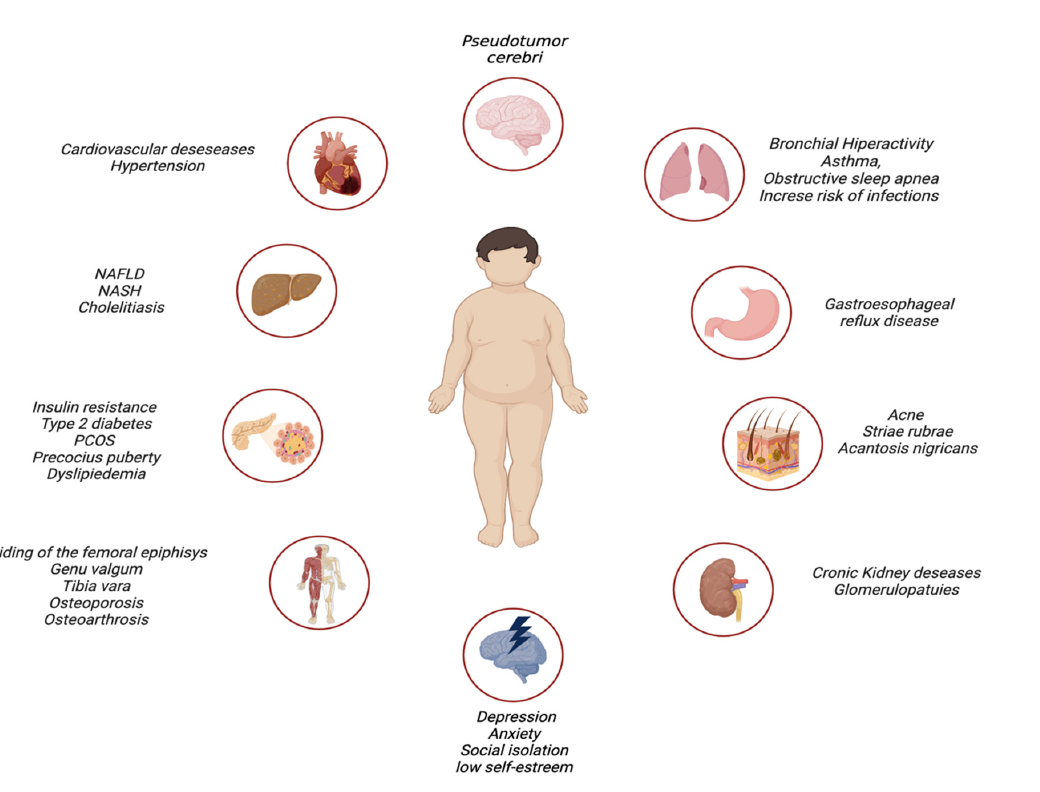
Figure 1. Comorbidities of obesity (created with BioRender.com (accessed on 15 March 2023)).